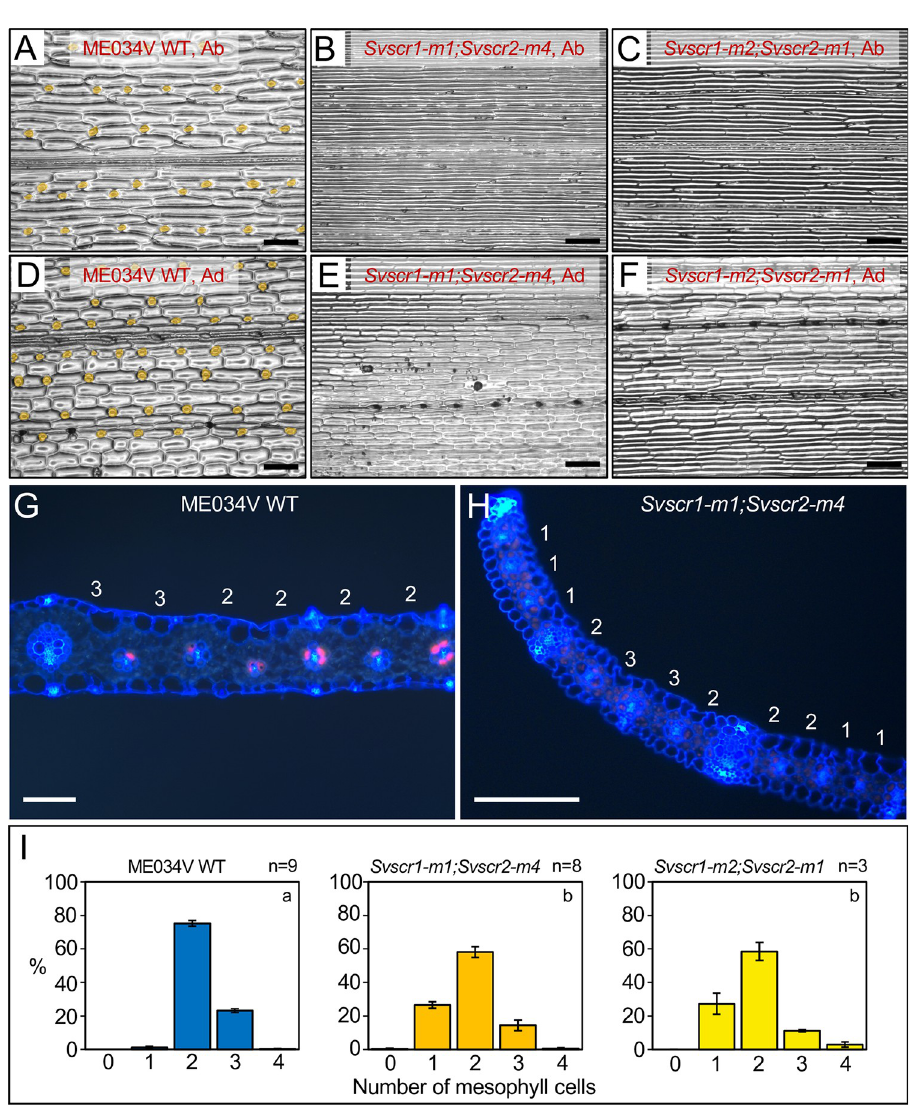
Fig 2. Svscr1;Svscr2 mutant plants have no stomata and fewer mesophyll cells separating veins. A-F) Stomatal impressions of wild-type (WT) ME034V (A,D), Svscr1-m1;Svscr2-m4 (B,E) and Svscr1-m2;Svscr2-m1 (C,F) leaf 3 from either the abaxial (A-C) or adaxial (D-F) surface. Stomata are false coloured orange. Scale bars: 100 μ m. G-H) Transverse sections imaged using UV illumination of WT ME034V (G) and Svscr1-m1;Svscr2-m4 (H) leaf 4, taken from the mid-point along the proximal-distal axis. The number of mesophyll cells between each pair of veins is indicated above the leaf. Scale bars: 100 μ m. I) Histograms summarizing the mean number of mesophyll cells separating veins in WT ME034V and two independent Svscr1;Svscr2 mutants. The number of biological replicates is indicated above each plot and letters in the top right corner of each plot indicate statistically different groups ( P � 0.05, one-way ANOVA and Tukey’s HSD) calculated using the mean number of mesophyll cells in each genotype (raw data in S1 Table).